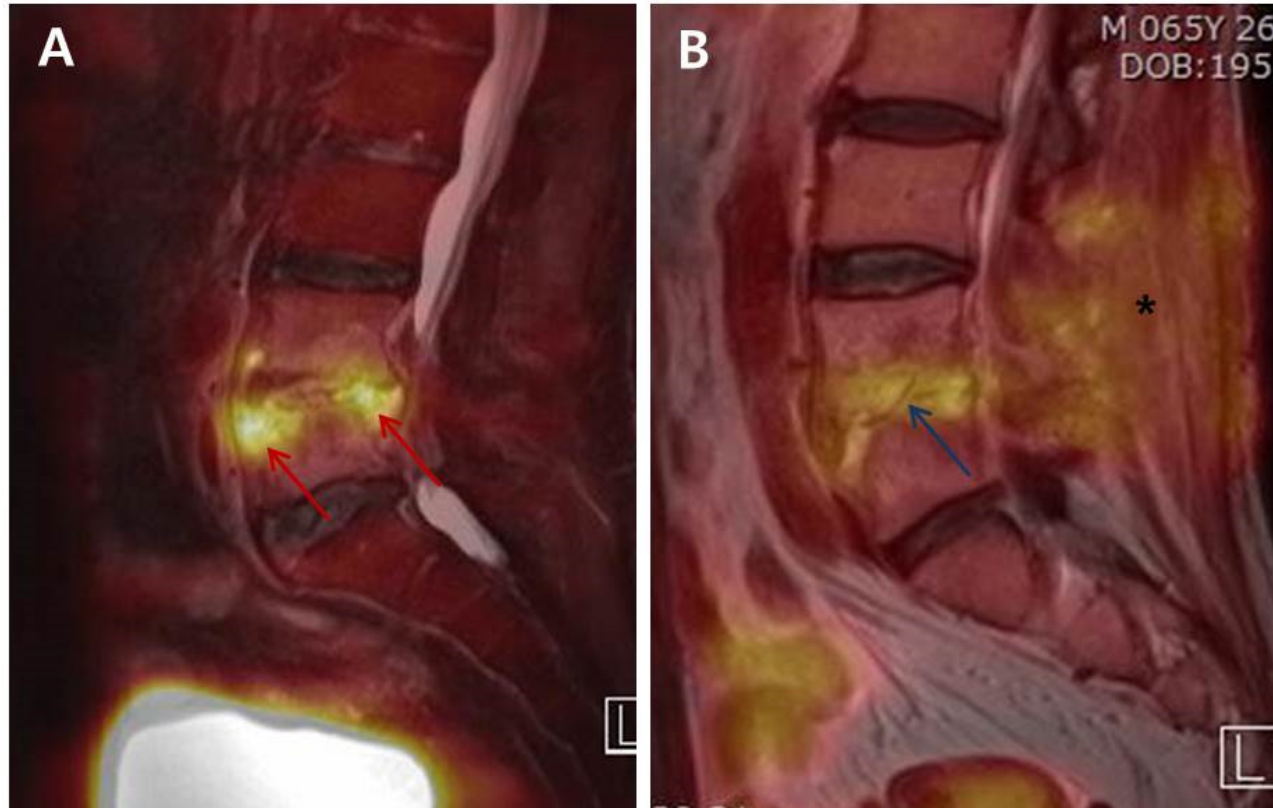
Figure 3. Differences in the intensity of FDG uptake between Uncontrolled (group UC) and Controlled (group C) simul- taneous 18 F-FDG-PET/MRIs. ( A ) The 60-year-old male patient diagnosed as PVO on L4–L5 was treated with empirical vancomycin and ciprobay under the no causative bacterial identification. The clinical assessment on the 36th day of parenteral antibiotic therapy showed sustained back pain, intermittent mild fever, and ESR/CRP of 57/7.726. 18 F-FDG- PET/MRI of group UC revealed an increased FDG uptake (red arrow; SUV max 9.26) on the anterior and posterior corners of upper L5 body and the disc of L4-L5. ( B ) The 65-year-old male patient diagnosed as postoperative PVO on L4–L5 was treated with nafcillin under the identification of MSSA. The patient showed alleviation in back pain, no fever, and ESR/CRP of 30/0.09 in the clinical assessment on the 35th day. The FDG uptake decreased overall and was limited to the disc and endplates (blue arrow; SUV max 3.82) on 18 F-FDG-PET/MRI of group C. There was also decrease in FDG uptake at posterior structures, including back muscle and fatty layer (asterisk). FDG, 18 F-fluorodeoxyglucose; PVO, pyogenic verte- bral osteomyelitis; MSSA, methicillin-sensitive Staphylococcus aureus ; ESR, erythrocyte sedimentation rate (mm/h); CRP, C-reactive protein (mg/dL); 18 F-FDG-PET/MRI, 18 F-fluorodeoxyglucose positron emission tomography/magnetic reso- nance imaging; SUV max , maximum standardized uptake value of FDG.